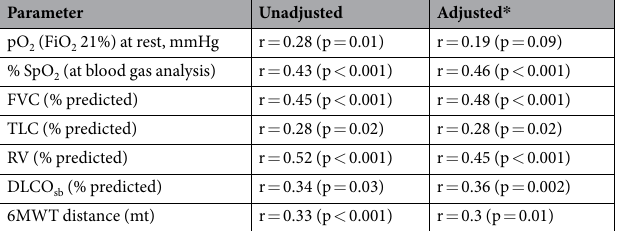
Table 3. Correlations of the CII with lung function and exercise performance at baseline in the investigated SSc patients. * Adjusted for disease duration and Body Mass Index. CII = computerized integrated index; SSc = systemic sclerosis; pO 2 = oxygen partial pressure; FiO 2 = fraction of inhaled oxygen; SpO 2 = oxygen saturation; FVC = forced vital capacity; TLC = total lung capacity; RV = residual volume; DLCO sb = single breath diffusion lung capacity for carbon monoxide; 6MWT = six-minute walk test; mt =